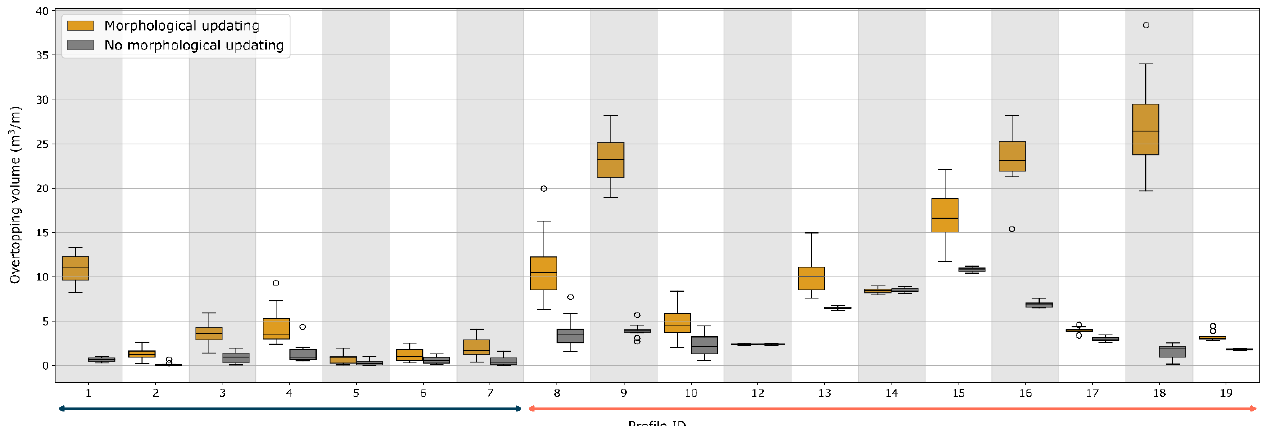
Figure 10. Influence of morphological change on total overtopping volume. Overtopping volume is the volume of water per unit width over the modeled time period (m 3 /m). Box plots represent the distribution of overtopping volumes arising from the 10 model runs performed for each representative profile. Unmanaged and managed profiles are indicated with blue and orange arrows, respectively. Identical wave input timeseries were used for comparison of with and without morphological updating enabled. Profile 11 has been omitted from this figure because the observed morphological change following the December 2013 storm surge (breaching) could not be simulated.